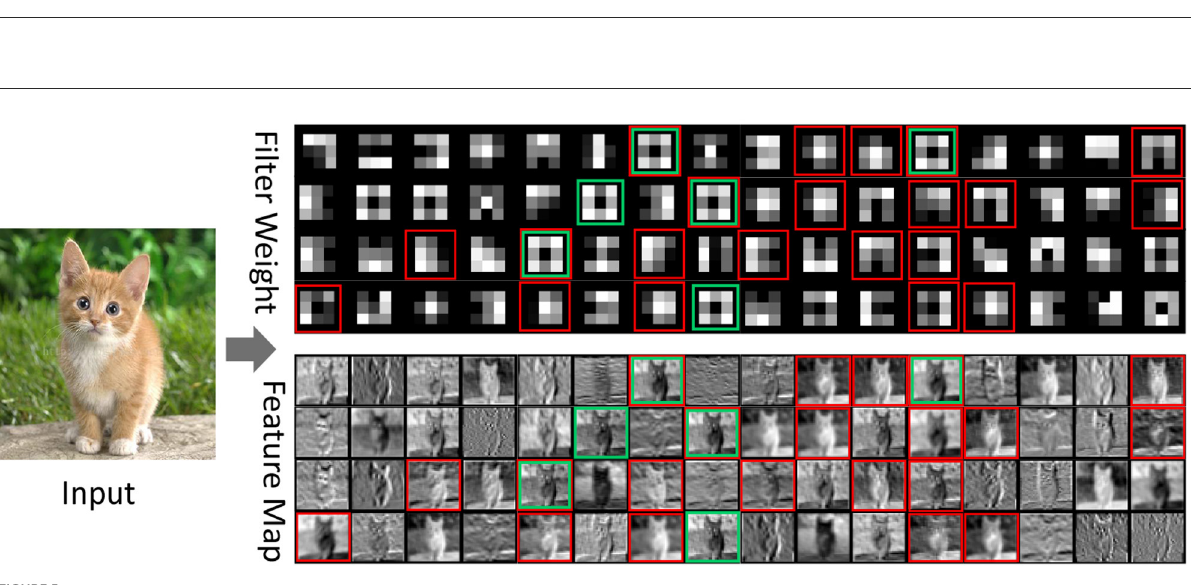
FIGURE5 Visualization of the weights and feature maps of the first convolutional layer of the VGG16 on the CIFAR100 datasets. The first convolutional layer has 64 filters, and the filters with red bounding boxes are to be pruned. The green boxes are similar channels artificially determined according to the feature map and the convolution kernel, while the green boxes and red boxes are the channels identified and pruned by the algorithm.